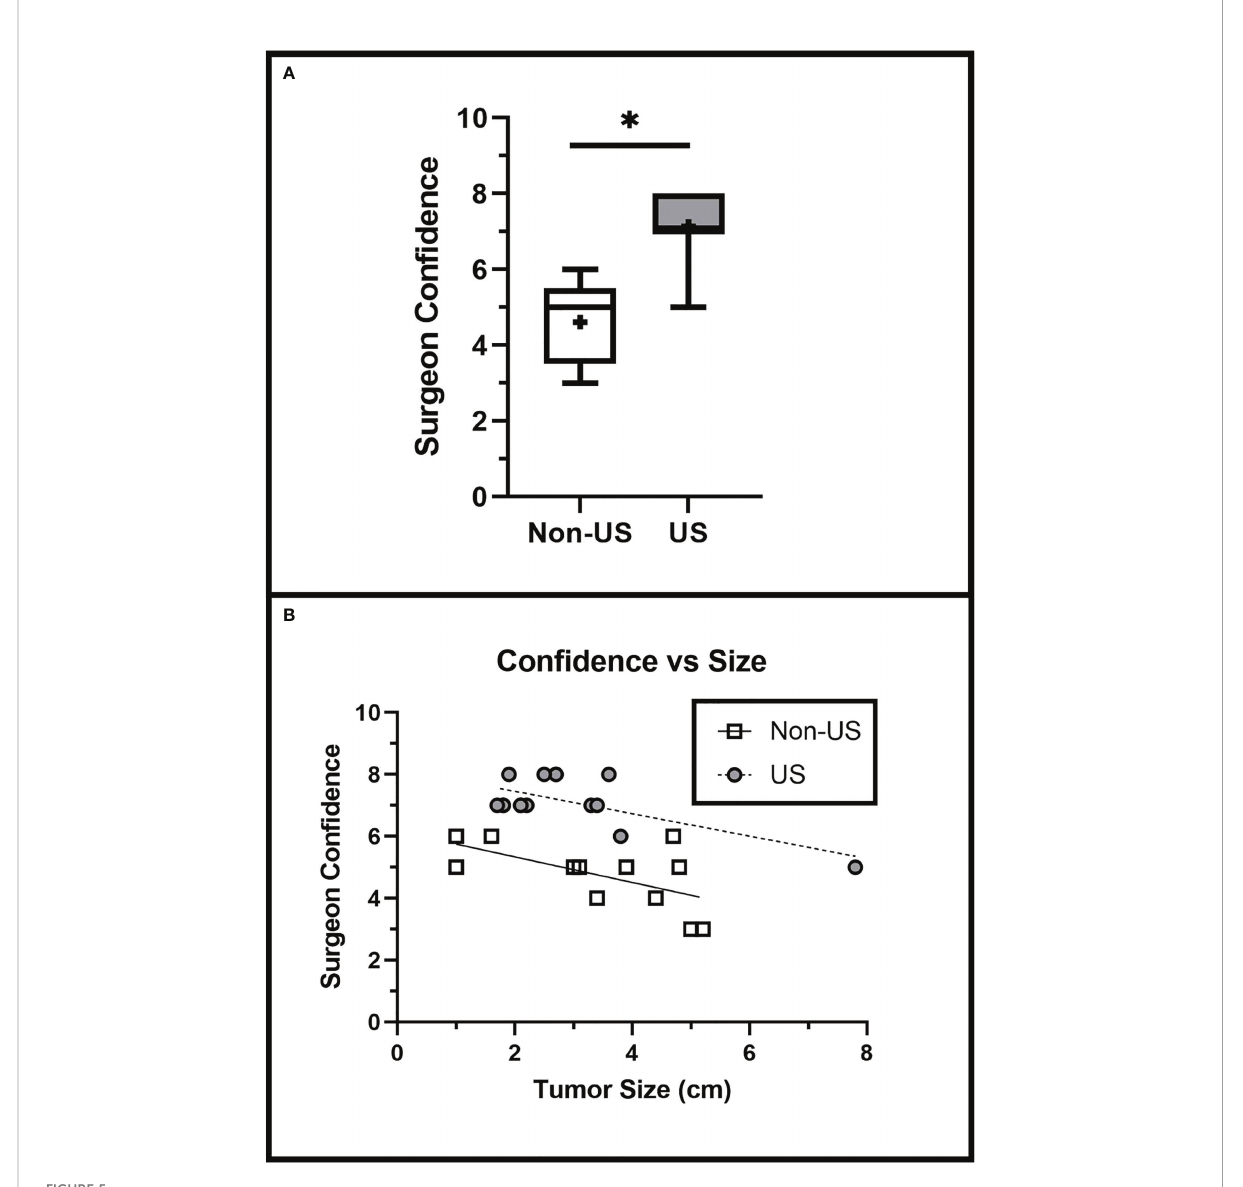
FIGURE 5 Surgeon Con fi dence is Increased with IOUS Use. (A) IOUS improved surgeon con fi dence in assessing the extent of tumor resection intraoperatively (p < 0.001). (B) Surgeon con fi dence was greater in the US group when adjusted for tumor size (Slope p = 0.7991, Intercept p = 0.02). Asterisks (*) indicate signi fi cance of p < 0.05. Crosses (+) indicate mean